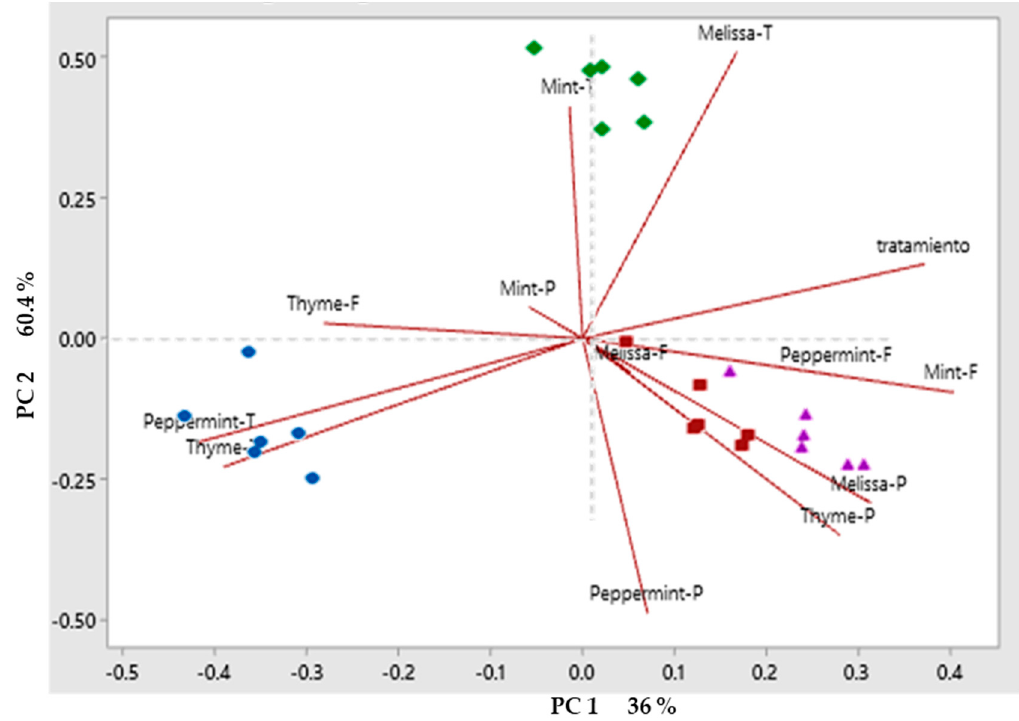
Figure 1. Principal component analysis (PCA) a) Phenolic compounds, flavonoids, tannins, by drying method and plant materials. [The di ff erent drying methods correspond to the Blue (Fresh plant), red (Microwave oven), green (Conventional) and violet (Freeze drying) icons] and [Acronyms per sample indicate P (Phenols), F (Flavonoids), and T (Tannins)] [Red line indicates the direction of the maximum variance of the data to orthogonal axes of each component].